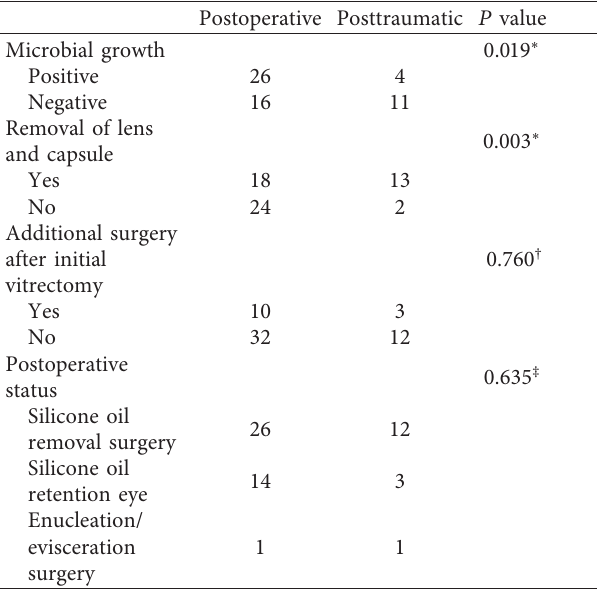
Table 2: Clinical outcomes between postoperative and posttrau- matic